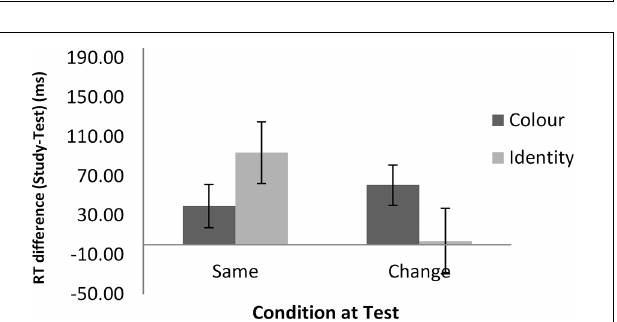
TABLE 2 | Means of median reaction times, expressed in milliseconds (ms), and percentage of errors (%) for the classification of equations in Experiment 1.